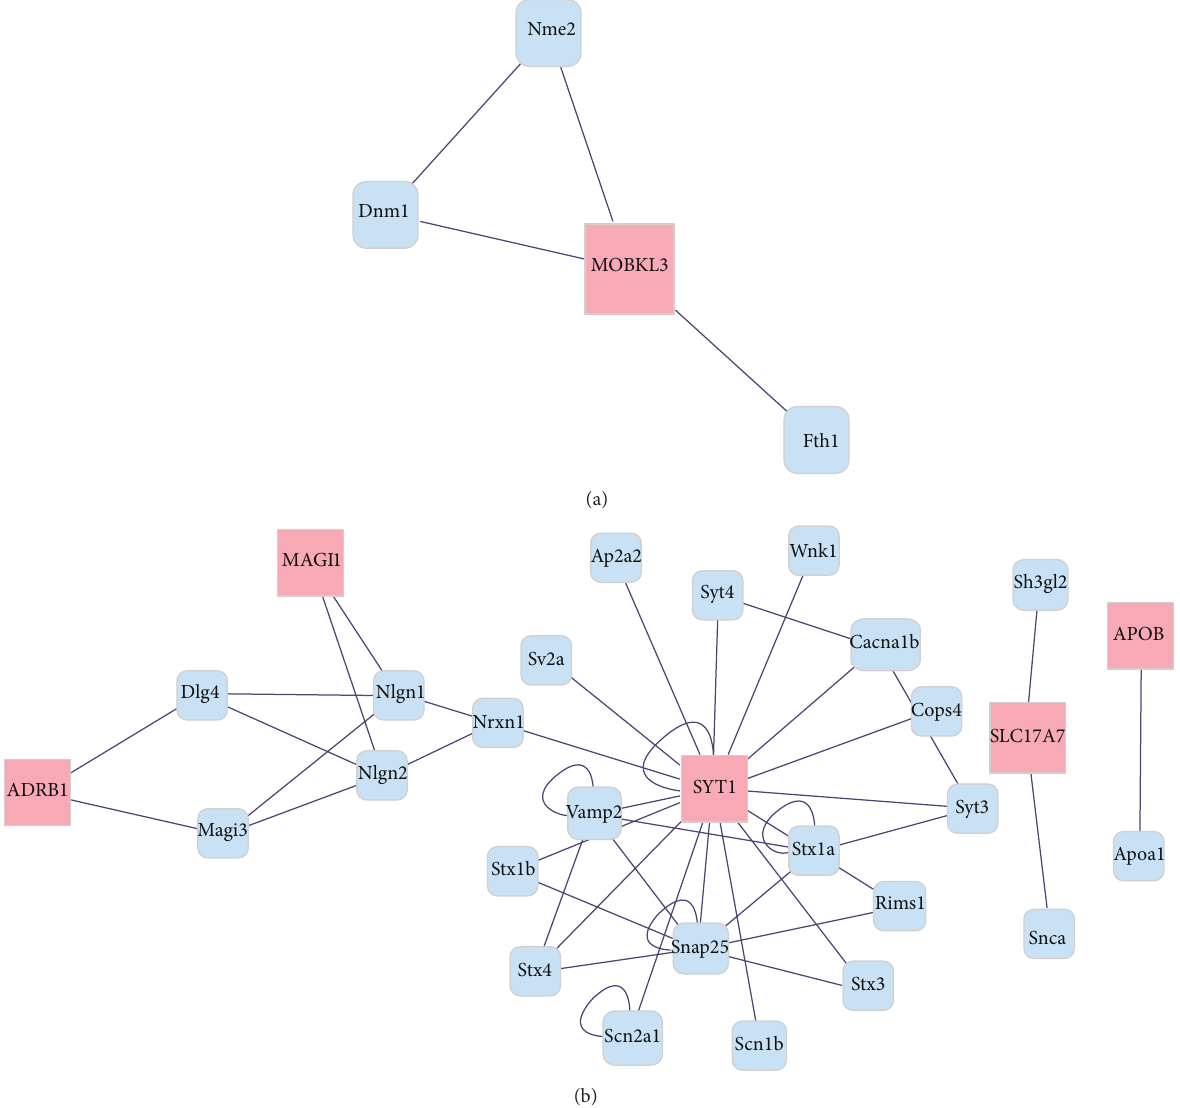
Figure 2: The interaction network of the obtained 87 DEGs. (a) The interaction network of 26 upregulated DEGs. (b) The interaction network of 57 downregulated DEGs. Red boxes: DEGs; blue boxes: reported gene in